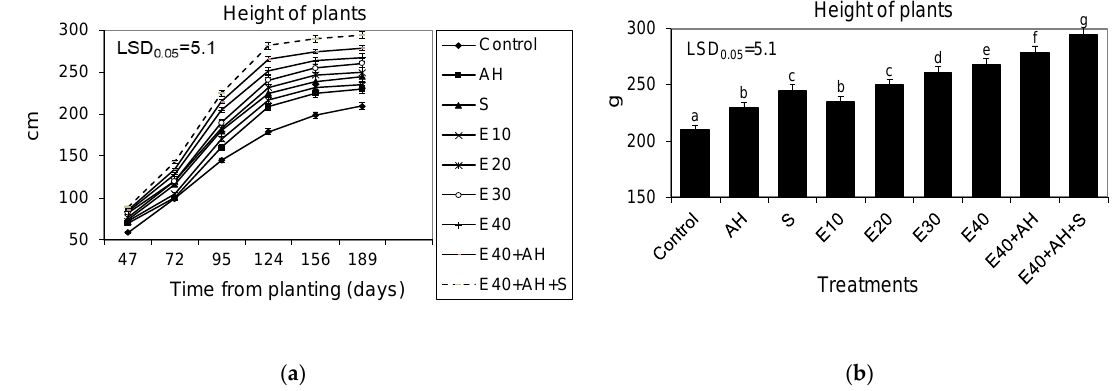
Figure 1. Kinetics of the growth ( a ) and final height of Jerusalem artichoke plants ( b ) cultivated in a field and fertilized with liquid, non-centrifuged waste from corn grain digestion to methane (E10, 40 m 3 ha −1 ), Apol-humus (AH; 10 L ha −1 ), and Stymjod (S; 5 L ha −1 ). The data marked with the same letters are not significantly different, according to the Newman–Keuls multiple range test at an alpha level of 0.05. The data presented are the average over the years and 10 plants in each repetition of a particular experimental variant.